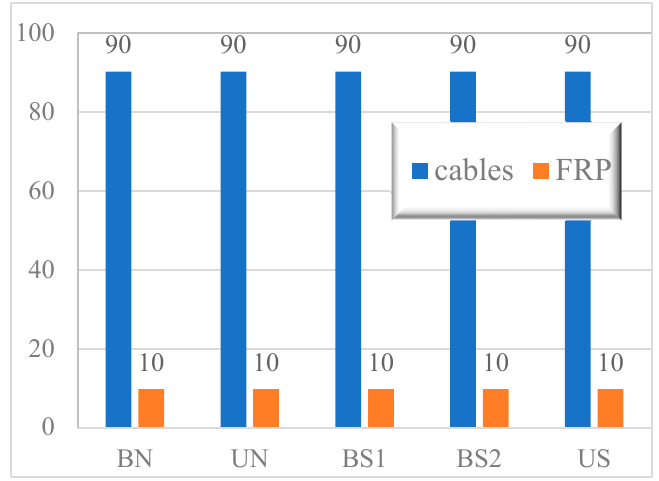
Figure 39. Strength contribution for 12 cables and 4 FRP laminates (3:1 ratio).